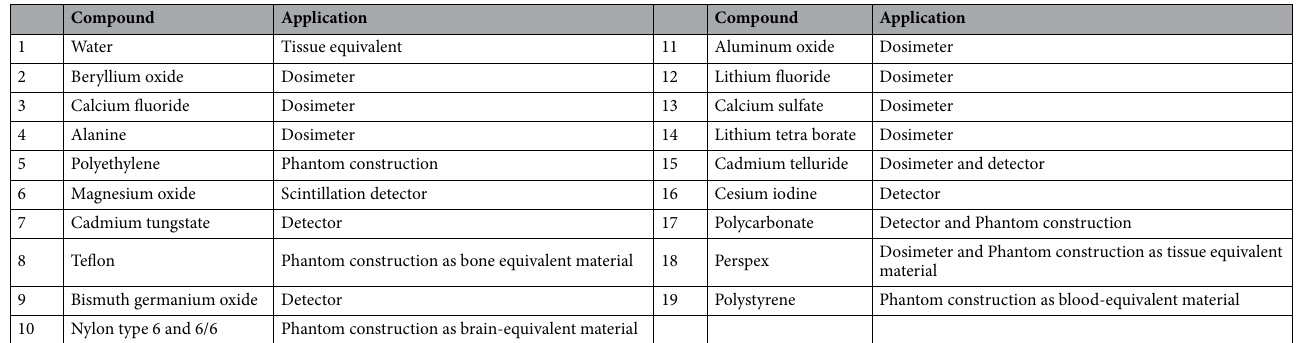
Table 1. Chosen compounds and their